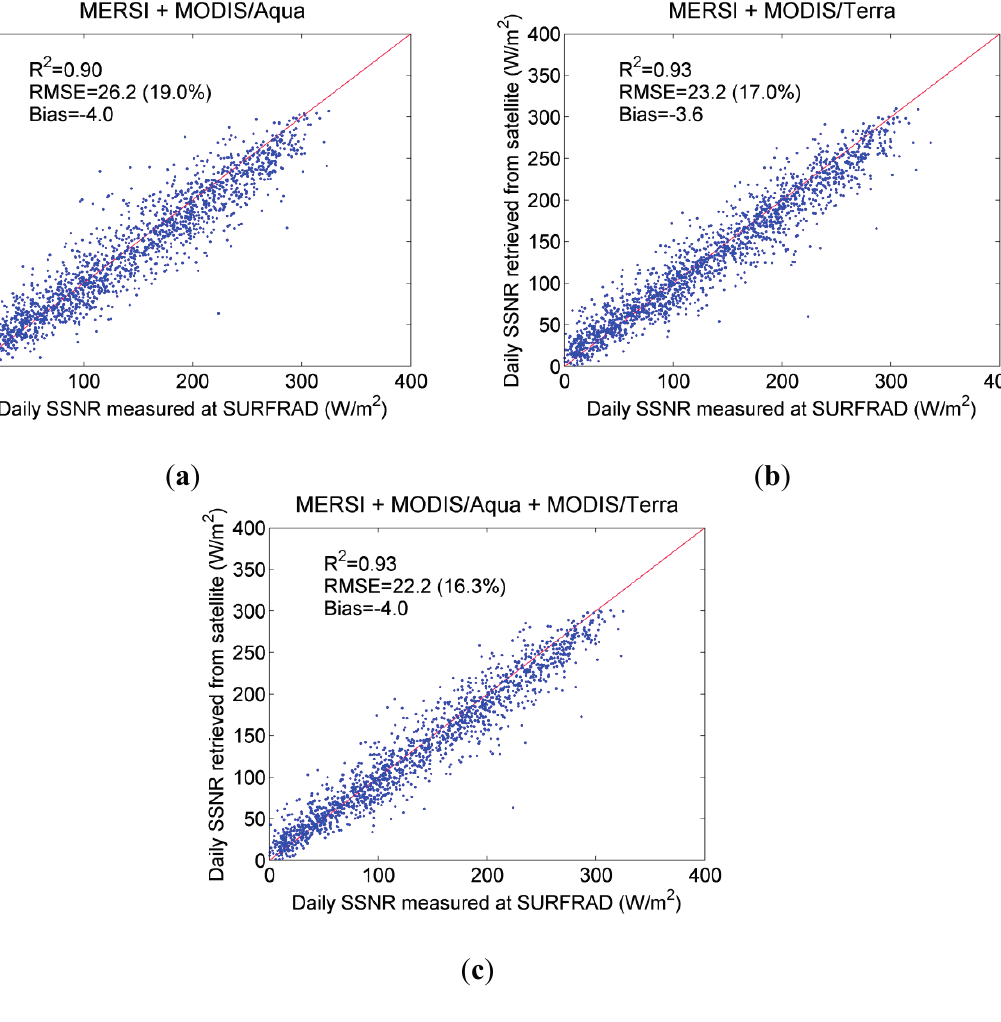
Figure 6. Validation results of daily SSNR by combining MERSI with MODIS data ( a ) from MODIS/Aqua only, ( b ) from MODIS/Terra only and ( c ) from twin MODIS